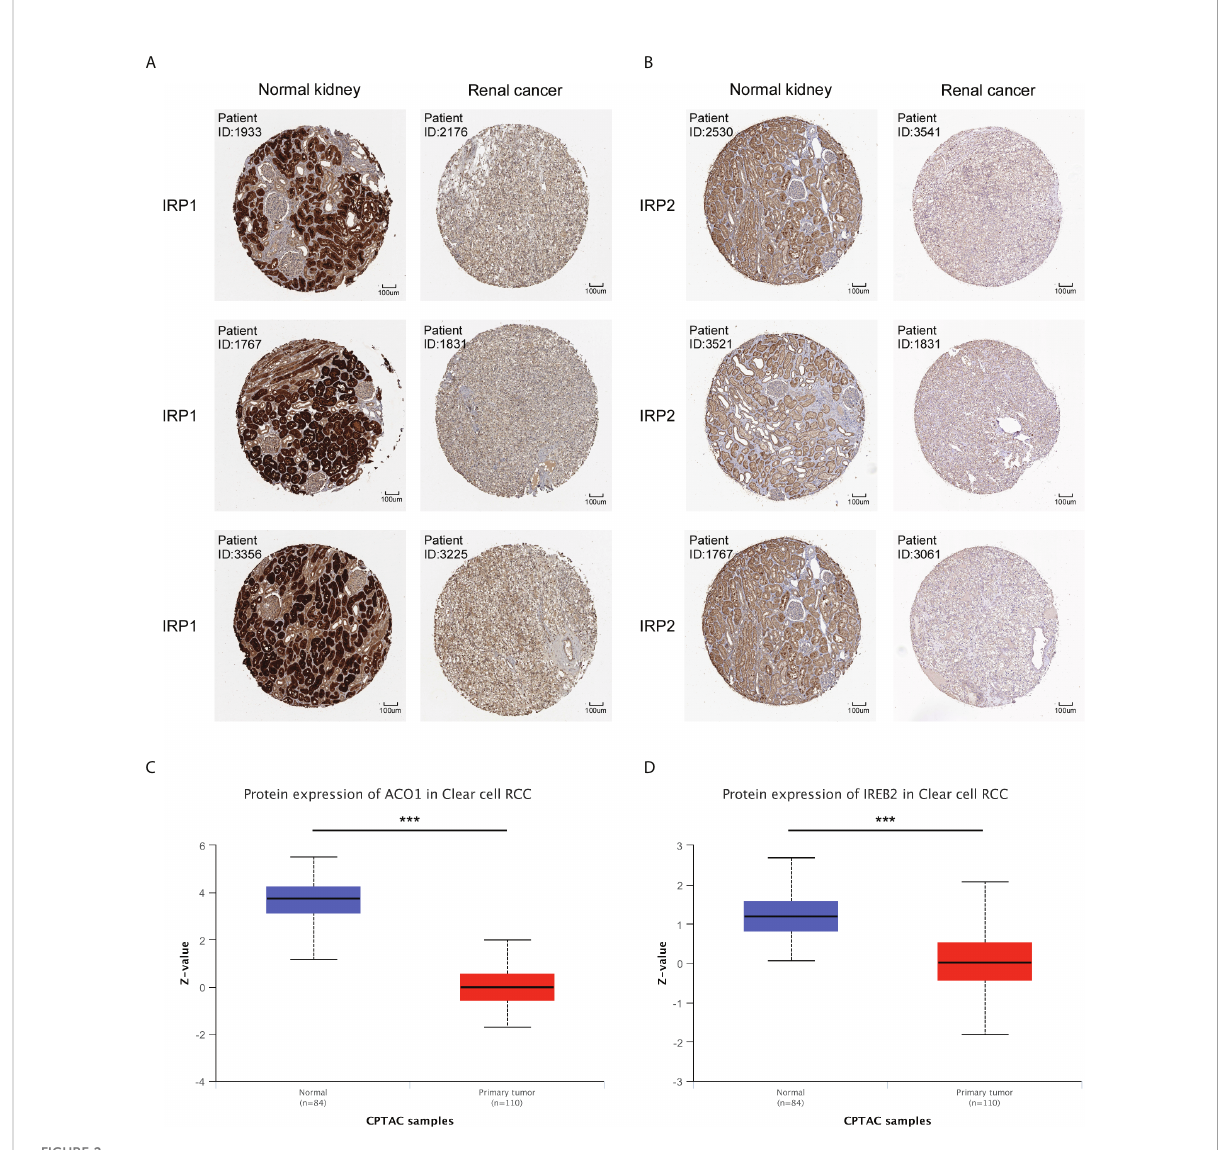
FIGURE 2 Protein expression of ACO1 and IREB2 in KIRC. (A, B) The protein expression levels of ACO1 (A) and IREB2 (B) by immunohistochemical staining from the HPA database (anti-ACO1 HPA024157, anti-IREB2 CAB032885, 10×). (C, D) ACO1 and IREB2 (D) protein expression in KIRC was analyzed by using the UALCAN database. ***P <